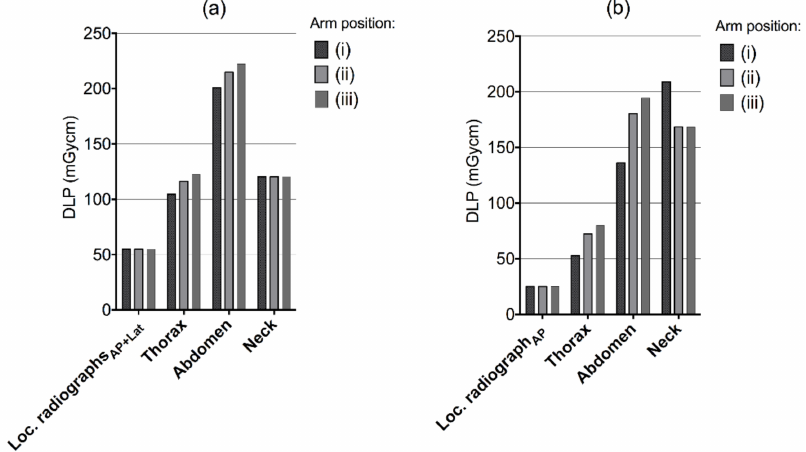
Figure 3. Dose-length products by helical scan for different scenarios of arm positioning in the CT localizer radiographs ((i), arms above head, (ii) arms along the trunk and (iii) arms along the trunk with hands placed on the abdomen) for ( a ) Canon Aquilion One and ( b ) Siemens Definition